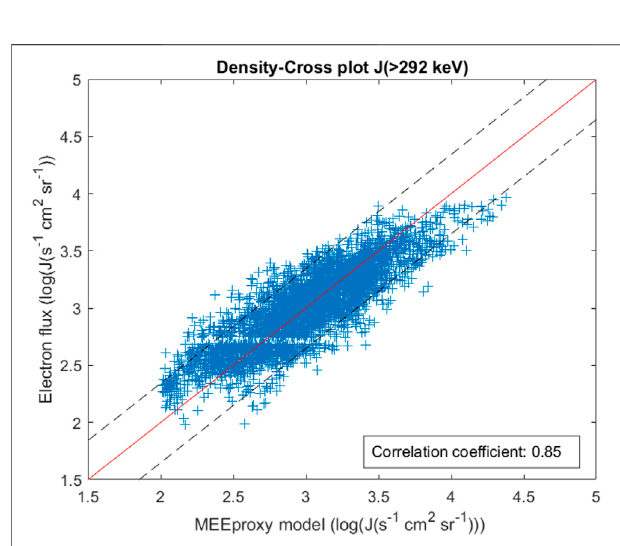
FIGURE 11 | Scatter plot of a linear fi t of the logarithmic value of the optimized MEE proxy and logarithmic value of the daily > 292 keV fl uxes. The black, dashed lines show the 95 and 5 percentile of the model errors.